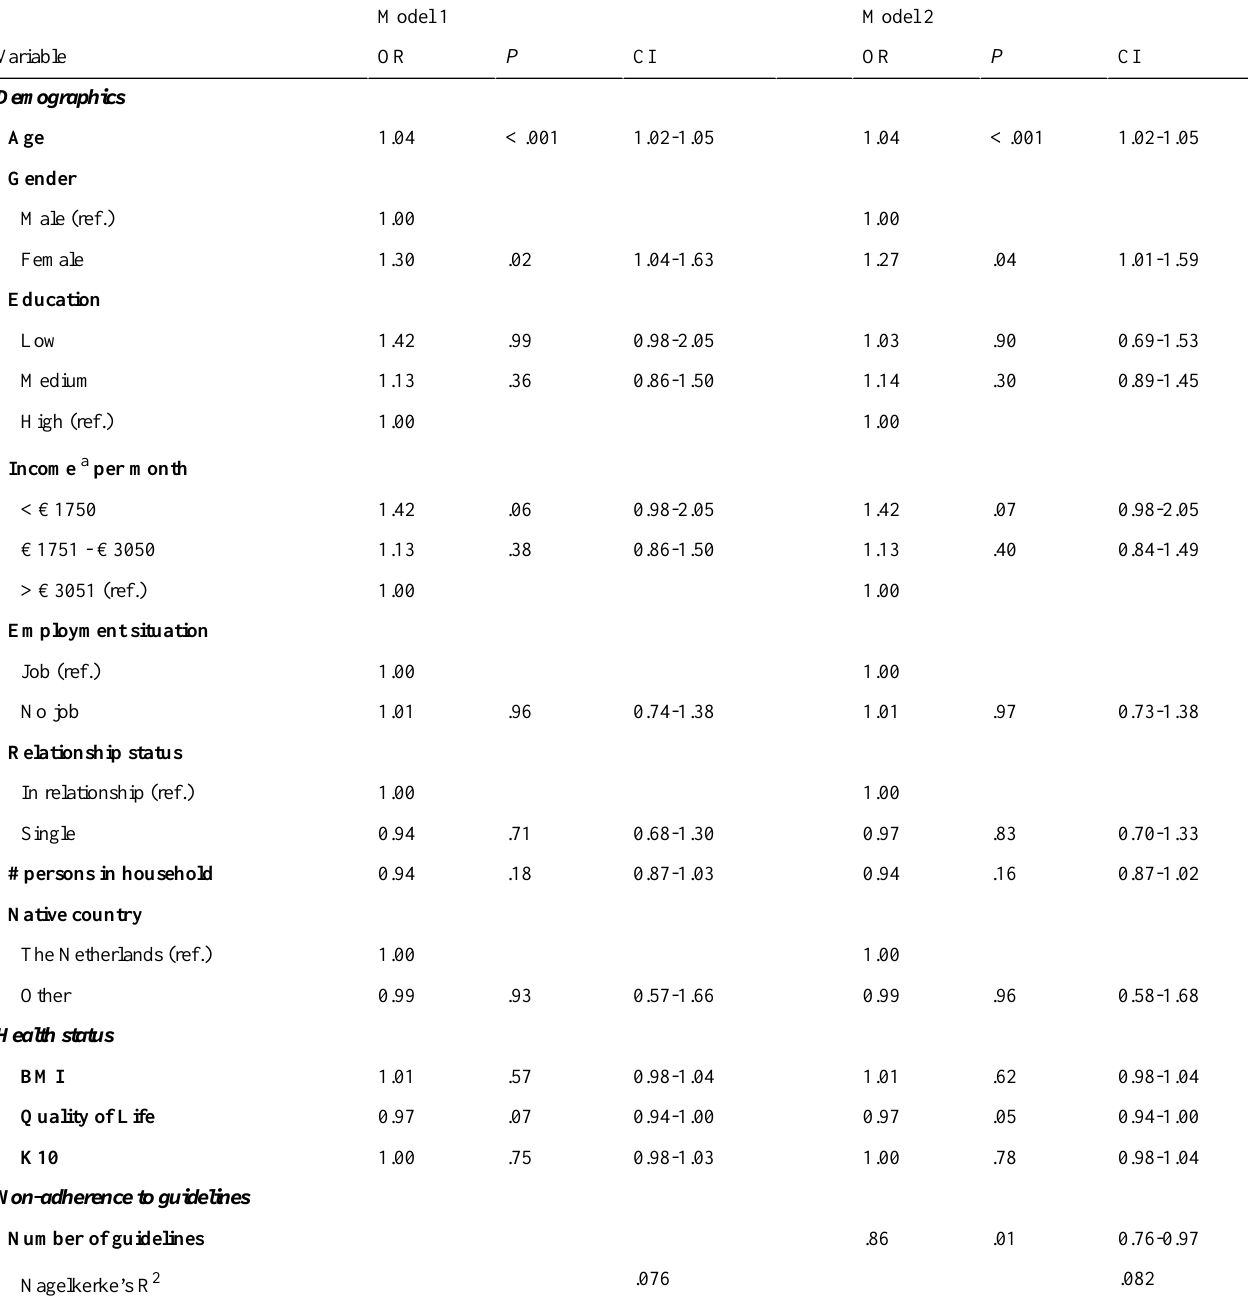
Table 3. Results of logistic regression analyses (Enter method) among the sequential condition on demographics and health status (model 1) and number of guidelines respondents failed to adhere to (model 2), with completion status (non-completers = 0; completers = 1) as dependent variable (N =